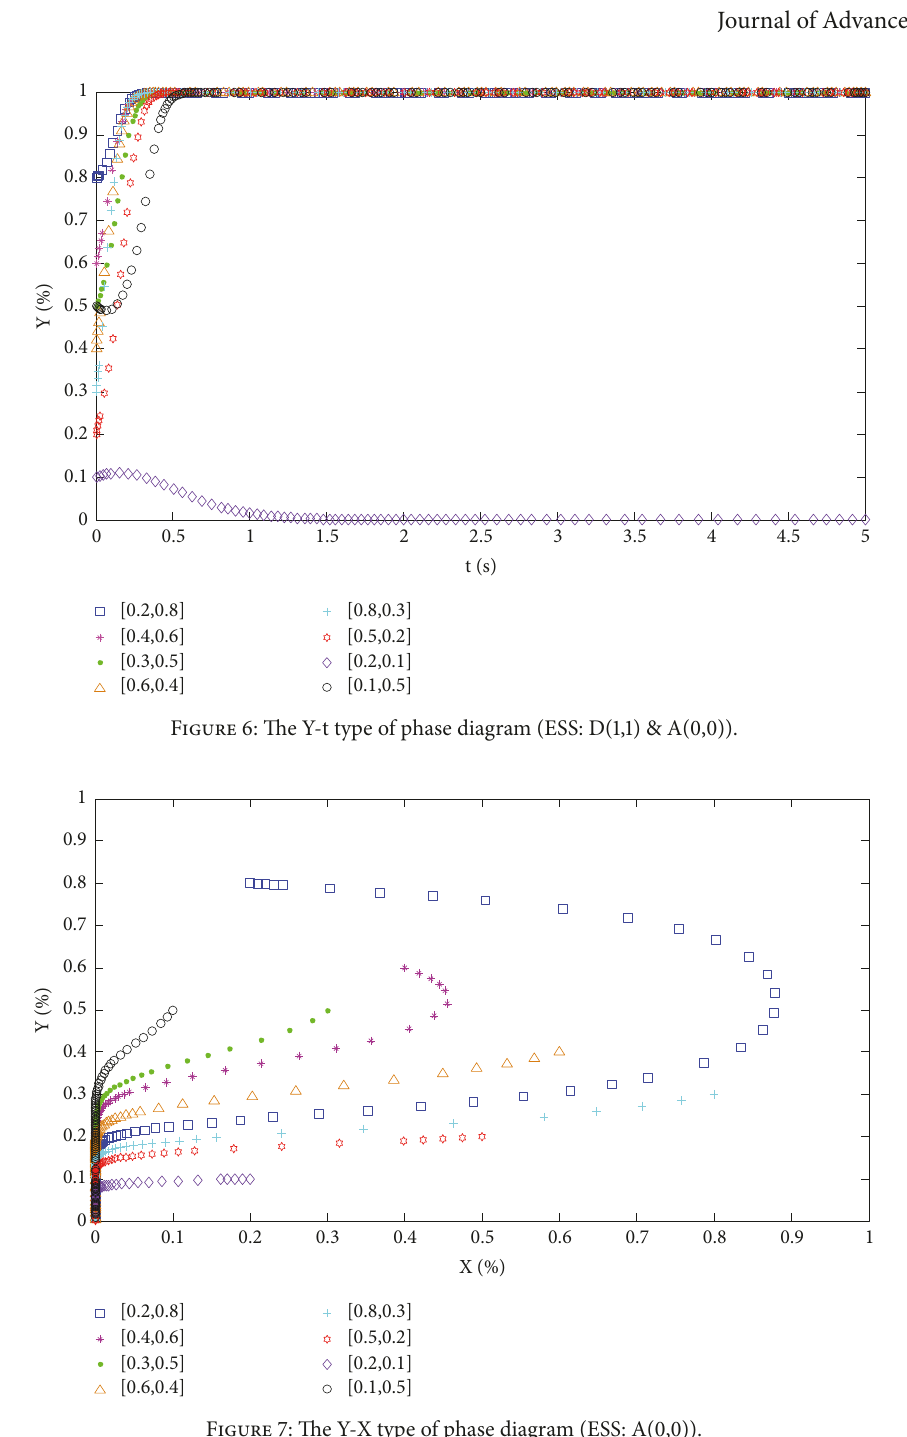
point E. Figure 7 presented the Y-X type of the phase